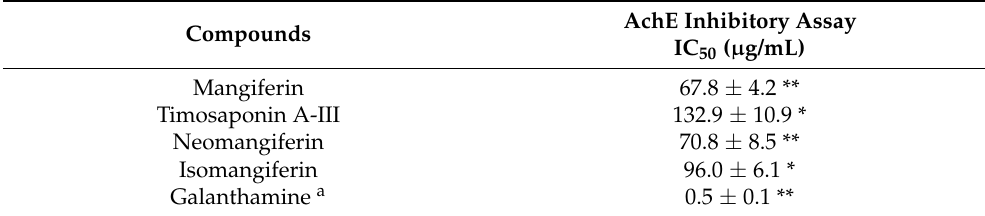
Table 8. Acetylcholinesterase (AChE) inhibitory assays of pure